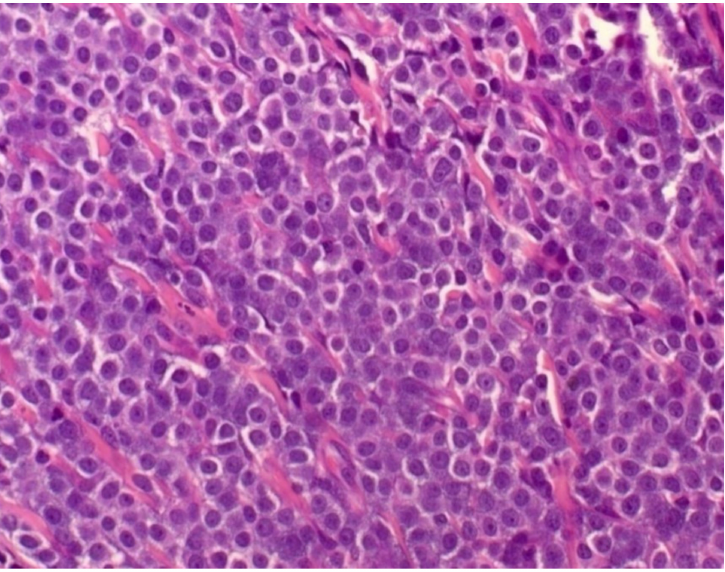
Figure 3. Photomicrograph of a canine mast cell tumor, revealing a round cell proliferation, with evi- dent nucleolus and moderate cytoplasmic granulation. Hematoxylin and eosin staining, Objective: 40 ×